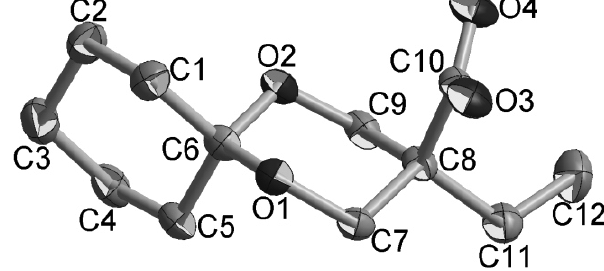
Table 2. Atomic coordinates and displacement parameters (in Å 2 )